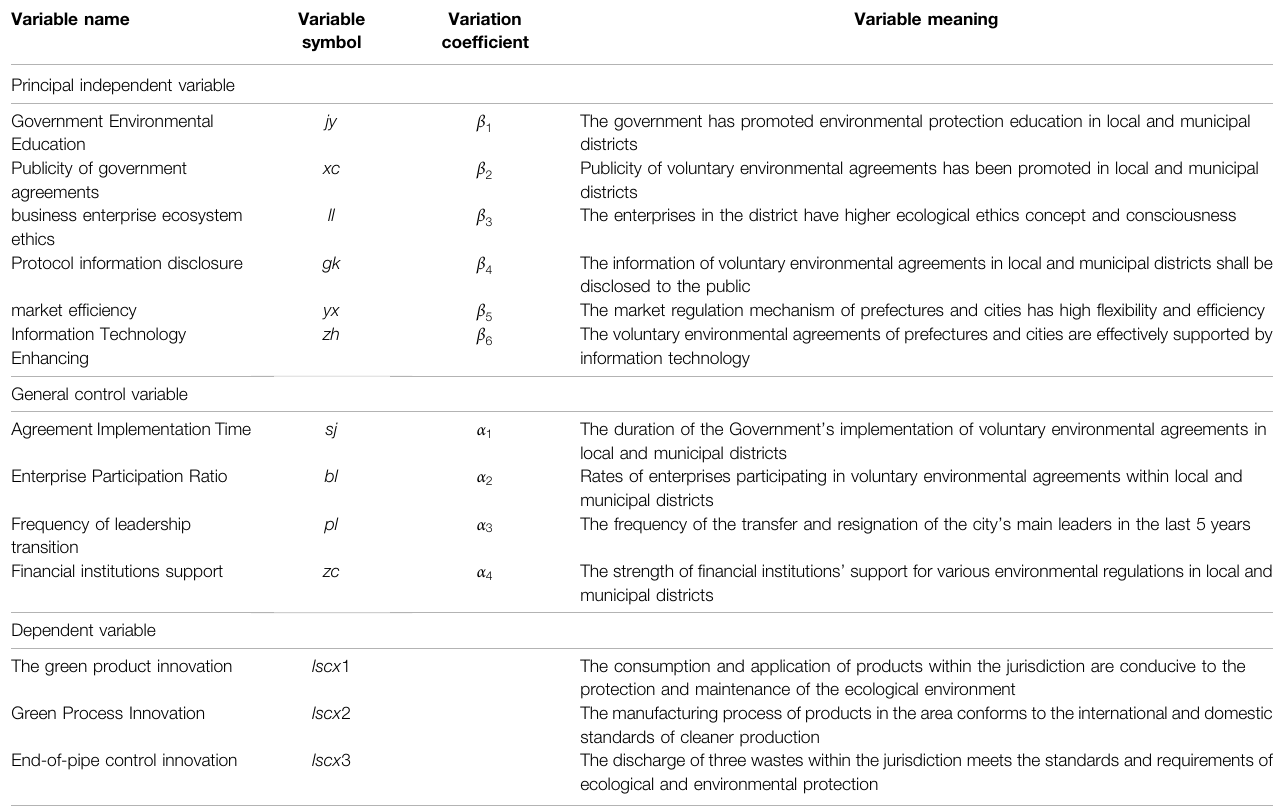
TABLE 1 | Variable